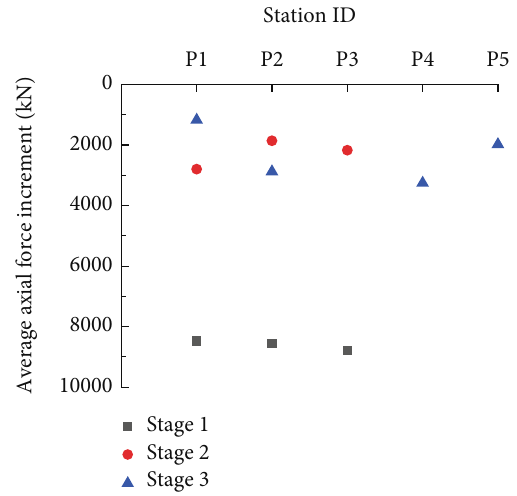
Figure 8: Axial force increment of steel pipe columns in three construction stages of the pile foundation station.